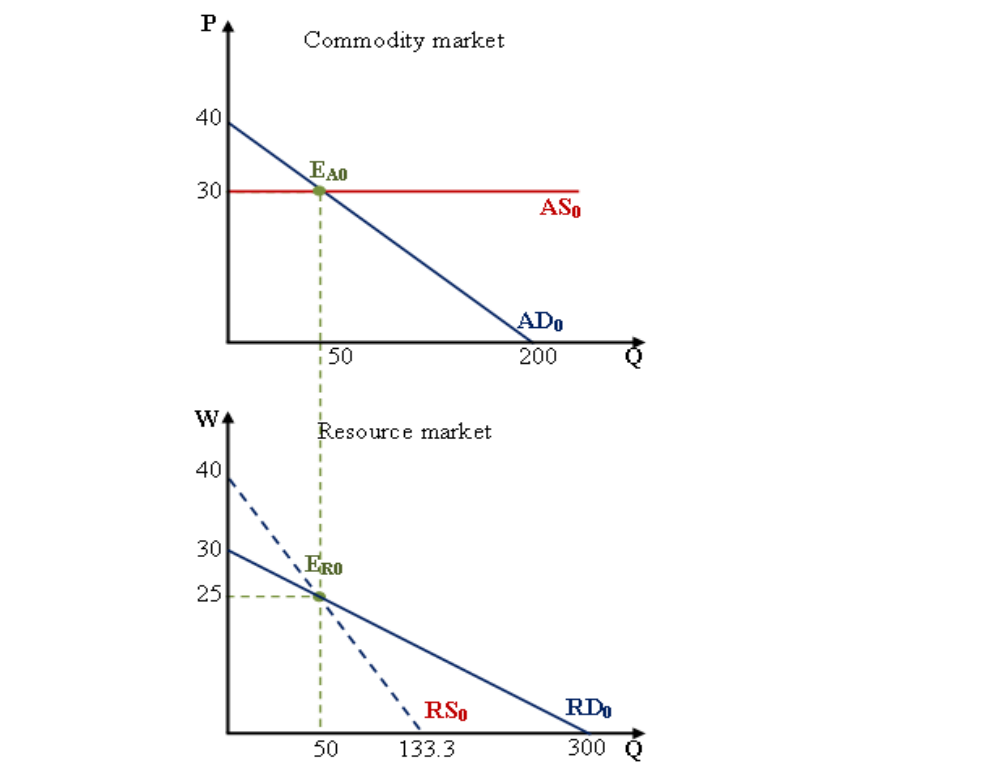
Figure 9. General equilibrium of the hypothetical economy.